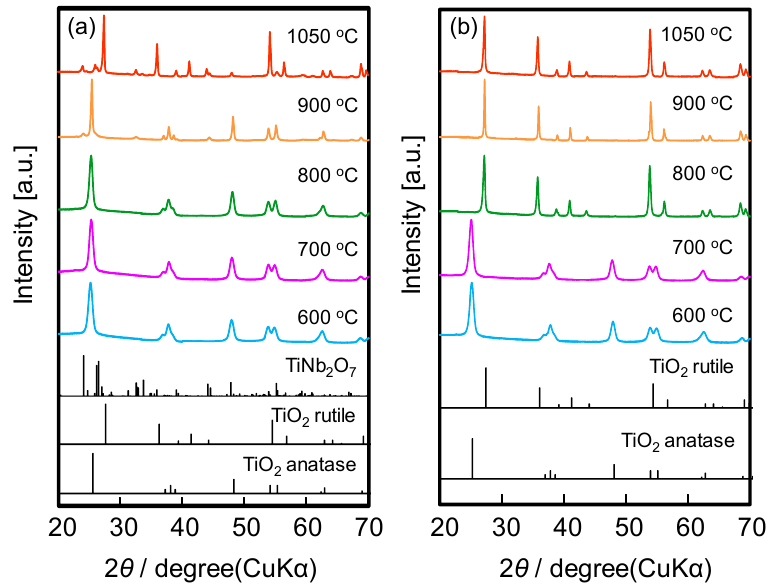
Figure 1. XRD patterns of titanium-niobium oxides prepared at 600, 700, 800, 900, and 1050 °C ( a ) in air and ( b ) in Ar containing 4% H 2